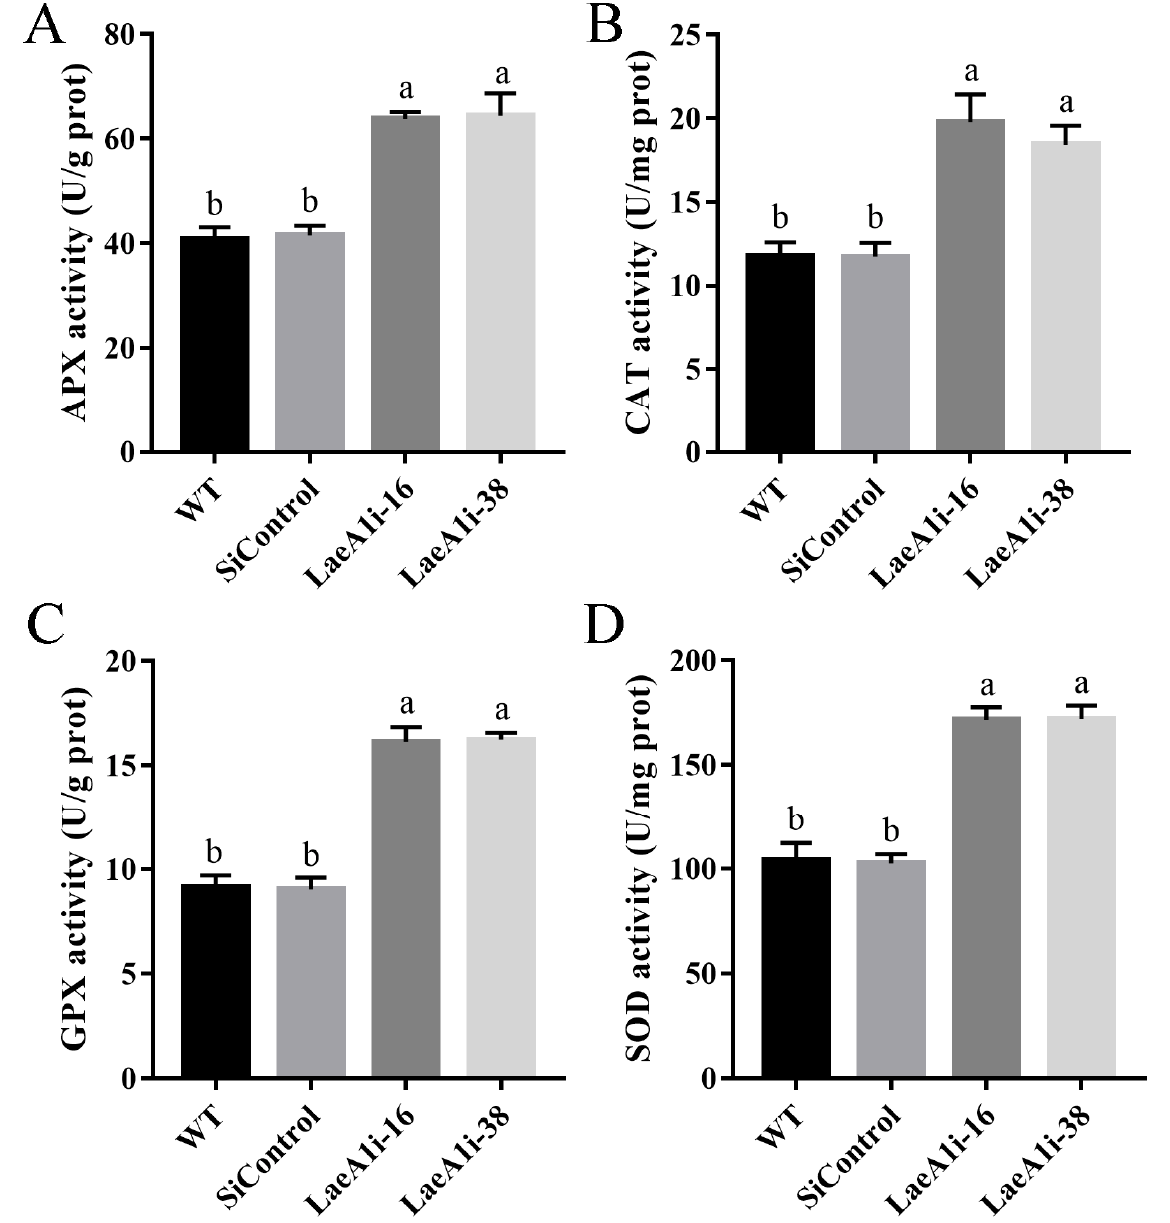
Figure 5. The activities of enzymes involved in the antioxidant system in PoLaeA 1-silenced strains. The P. ostreatus strains (WT, SiControl, LaeA1i-16 and LaeA1i-38) were cultured in liquid CYM at 28 °C for 5 days. The grounded mycelia were suspended in phosphate-buffered saline buffer. After centrifuging, the supernatants were used to detect the enzyme activities involved in ROS scavenging. ( A ) APX activity. ( B ) CAT activity. ( C ) GPX activity. ( D ) SOD activity. The values are the mean ± SD ( n = 3). Different lowercase letters indicate significant differences between the strains ( p < 0.05, according to Dunnett’s multiple comparisons test).